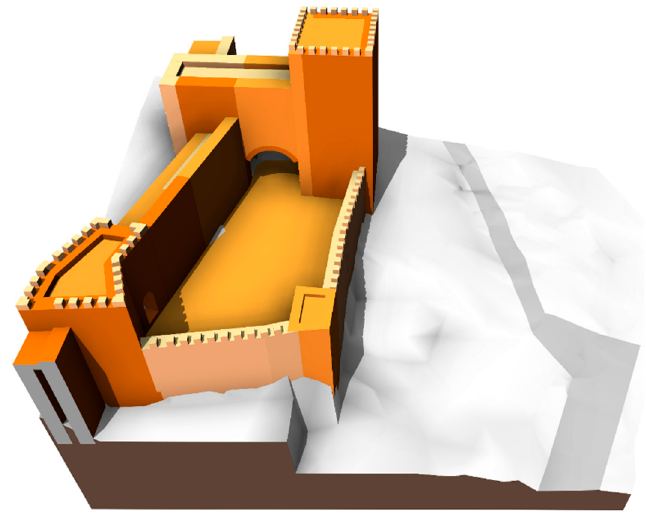
Figure 13. Virtual recreation of the hypothesis proposed in the studied area executed in IFC in a collaborative way.